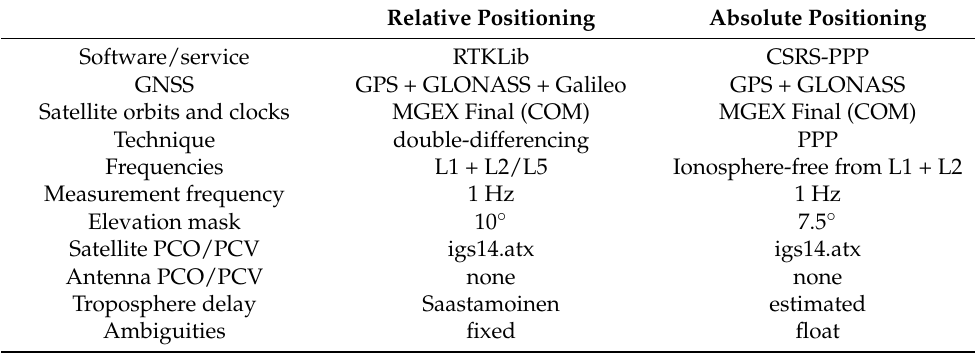
Table 1. Processing strategies for the relative and absolute positioning. Relative Positioning Absolute